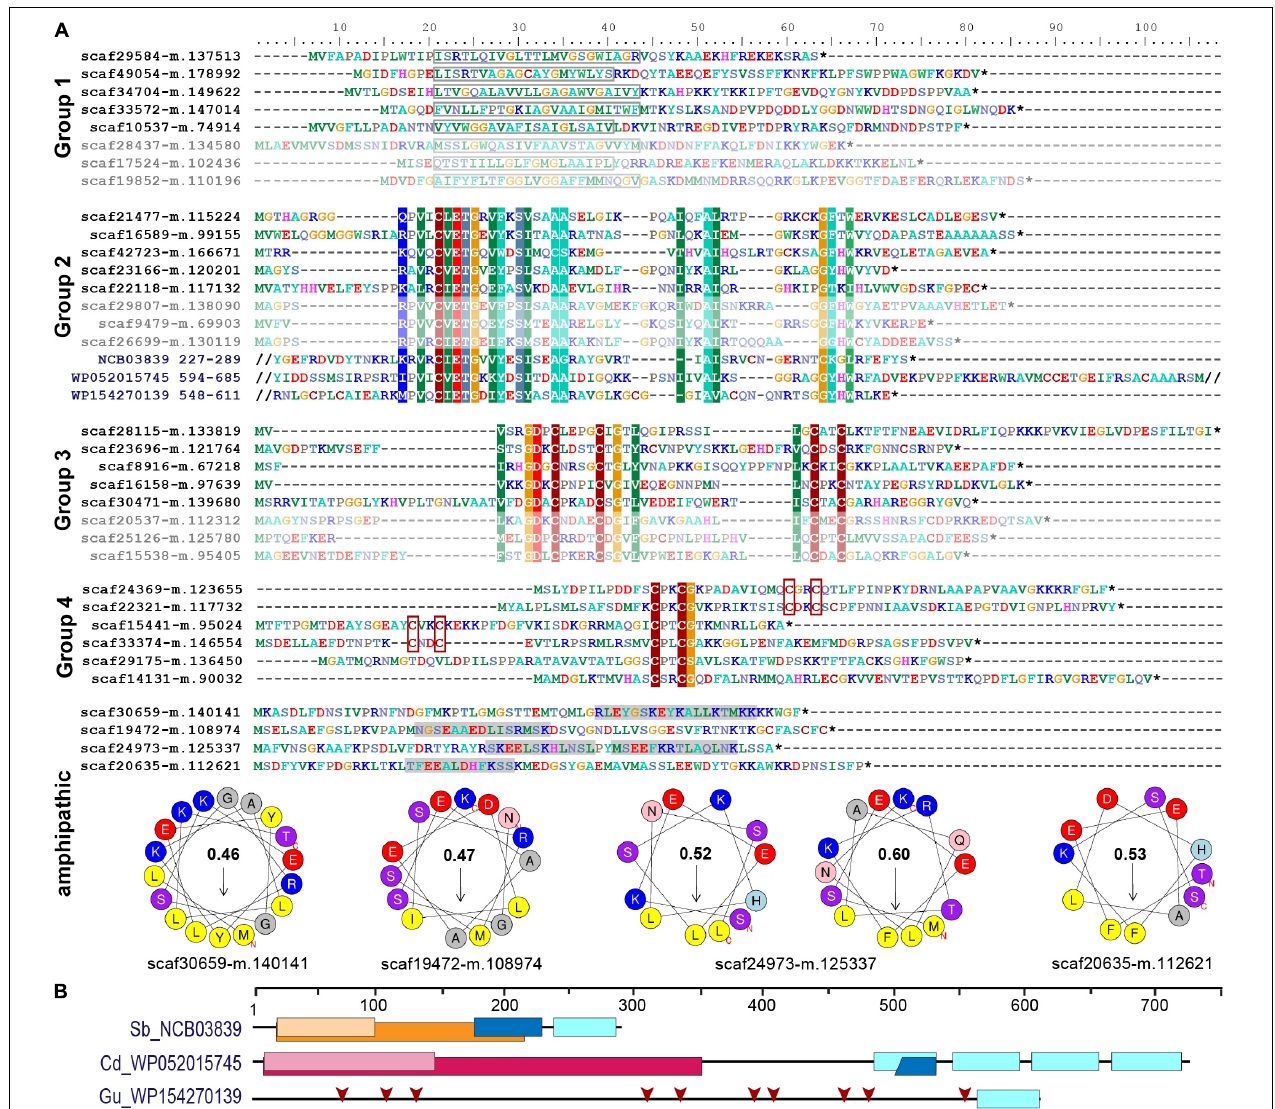
FIGURE 4 | Short orphan import candidates form distinct groups. (A) For each group, representative MS-identified proteins (bright colors) and, if applicable, similar proteins identified among translated nuclear transcripts (pale colors) are displayed. Group 1: boxes indicate position of the predicted TMH. Groups 2–4: colored background indicates ≥ 70% amino acid identity over alignments containing all MS-identified proteins of the respective group. The conserved sequence motif in group 2 was identified in diverse bacterial proteins (three examples with their NCBI accession number and amino acid positions are provided). Group 4: CxxC motifs are highlighted. Amphipathic: some short import candidates that do not belong to groups 1–4 feature amphipathic helices. Areas highlighted in gray contain predicted alpha-helices. Corresponding wheel diagrams and hydrophobic moments are provided below. (B) Domain structure of bacterial proteins shown in (A) . Light blue boxes, conserved group 2 sequence motif; orange, group I intron endonuclease domain; light orange, GIY-YIG excision nuclease domain; pink, Superfamily II DNA or RNA helicase domain (SSL2); light pink, DEXH-box helicase domain of DEAD-like helicase restriction enzyme family proteins; blue, DNA-binding motif found in homing endonucleases and related proteins (NUMOD); red arrows, individual CxxC motifs. Sb, Spirochaetia bacterium ; Cd, Clostridioides difficile ; Gu, Gordonibacter urolithinfaciens